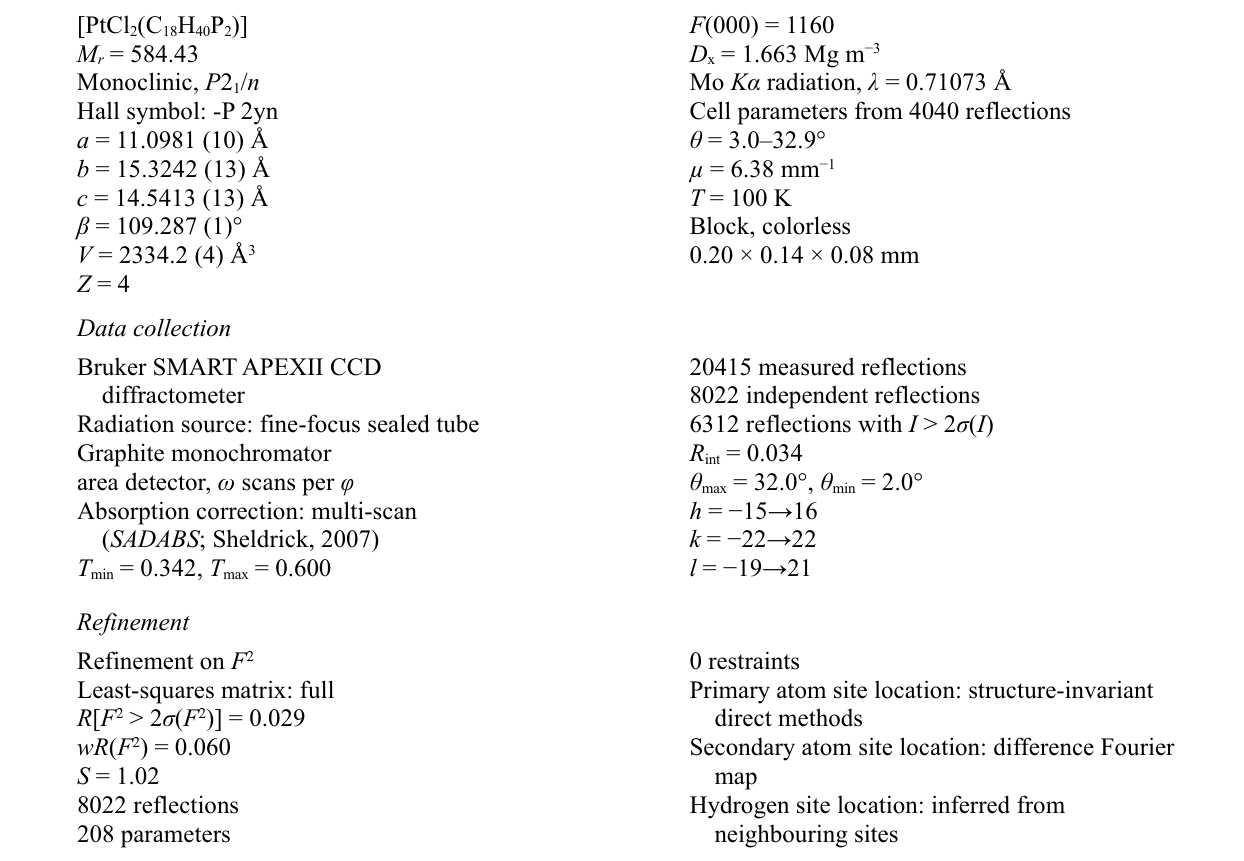
Figure 1 Displacement ellipsoid (50% probability) drawing of (I) with H atoms omitted. [1,2-bis(di- tert -butylphosphino)ethane]dichloridoplatinum(II) Crystal